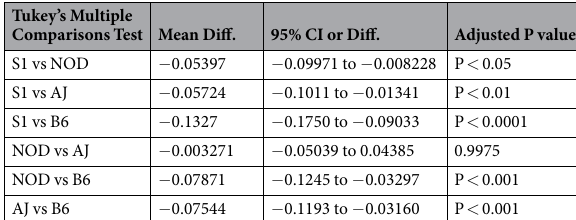
Table 3. Statistical table describing the multiple comparisons made (1-way ANOVA, Tukey’s post hoc test) in Fig. 1, panel H, between mouse strains during the 3 hr intermittent exposure to